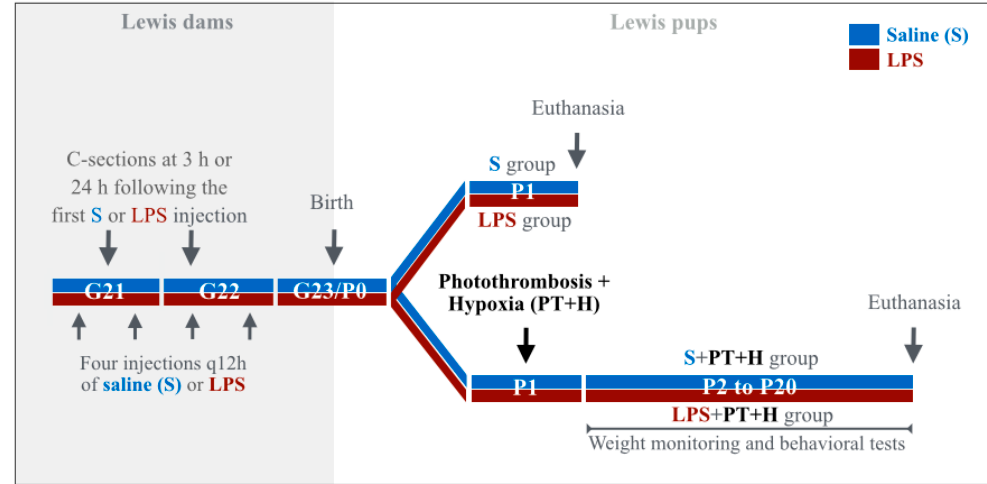
Figure 8. Summary of the experimental designs used for each animal subgroup. Abbreviations: G, gestational day; H, hypoxia; LPS, lipopolysaccharide; P, perinatal; PT, photothrombosis; q, every (from Latin quaque ); S, saline.